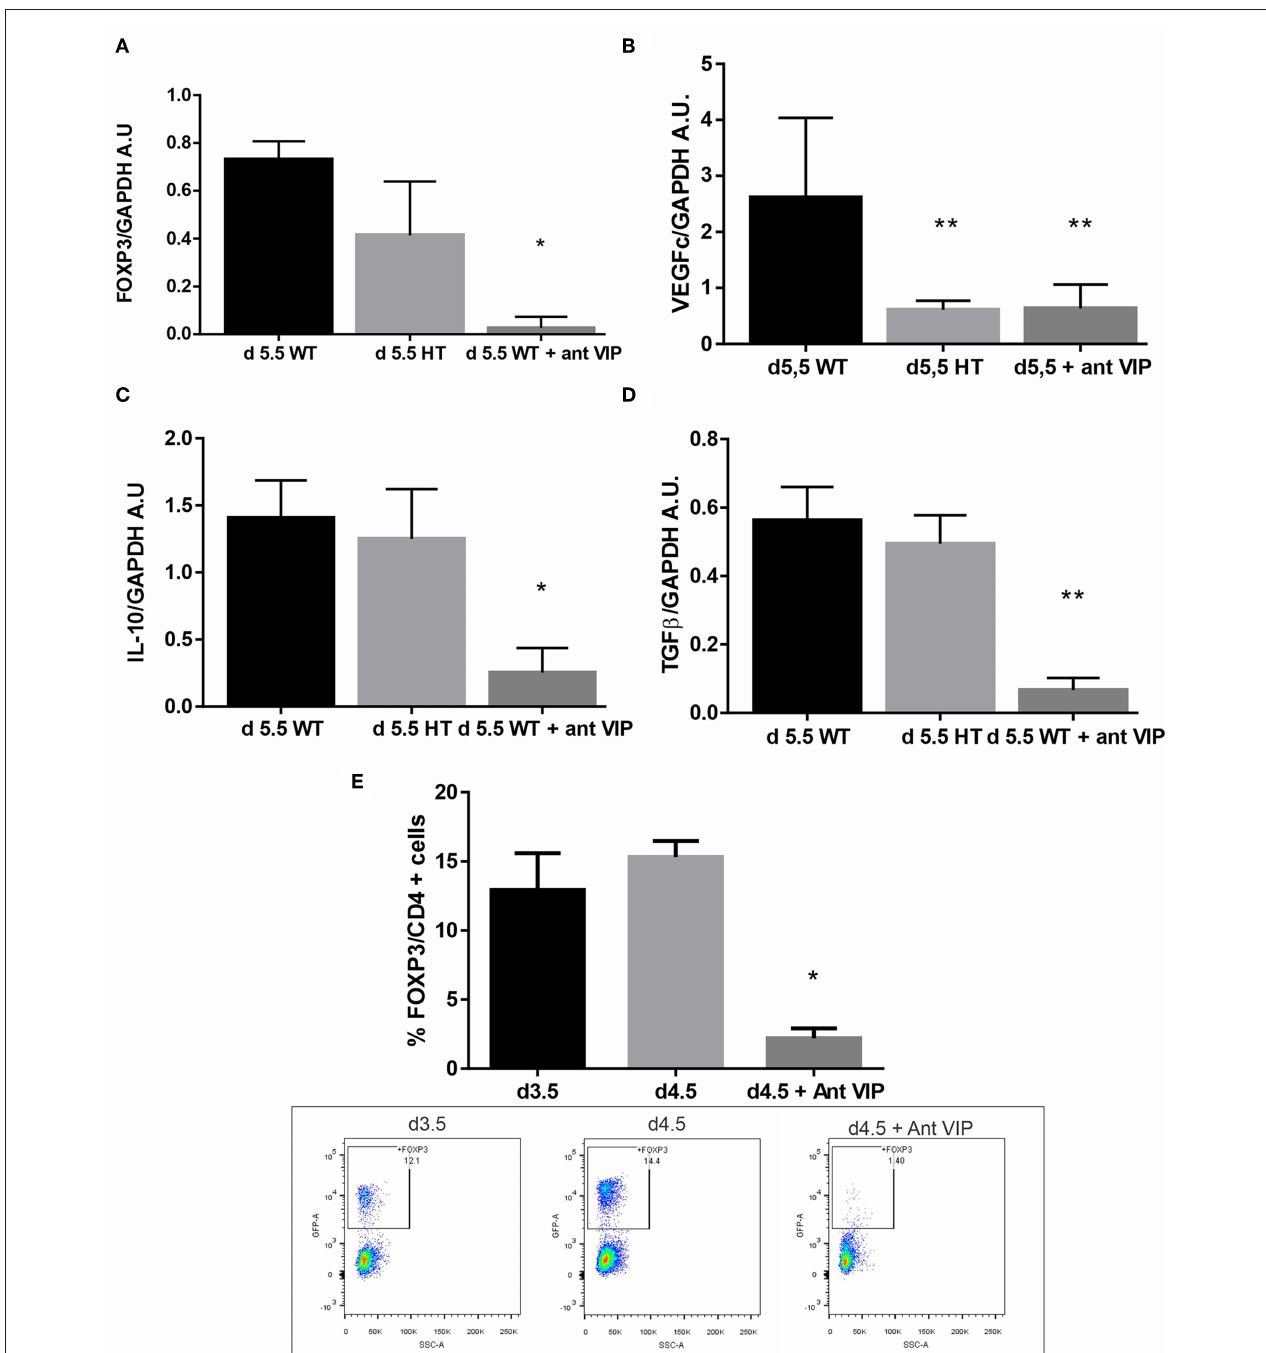
FIGURE 4 | Vasoactive intestinal peptide (VIP)-deficient mice showed a reduction of FOXP3 expression at the implantation sites. VIP + / + , VIP + / − , or VIP + / − pregnant female treated with VIP antagonist at d3.5 were sacrificed at d5.5, and FOXP3 expression and other pro-implantatory markers were evaluated by RT-PCR. (A) FOXP3, (B) VEGFc (C) , IL-10, and (D) TGF β expression. Bands were semiquantified with ImageJ ® , and intensity was expressed in arbitrary units (AU) relative to GAPDH. Values represent mean ± SEM of at least three experiments (Mann-Whitney test * p < 0.05). (E) shows the frequency of CD4 + FOXP3 + cells at the implantation sites in the peri-implantation period and the significant reduction of Treg frequency at day 4.5 caused by the injection of VIP antagonist at day 3.5. The lower panel shows representative dot plots with the % of FOXP3 cells (inside the electronically gated CD4 + cells) (Mann-Whitney test * p < 0.05 and ** p < 0.01).